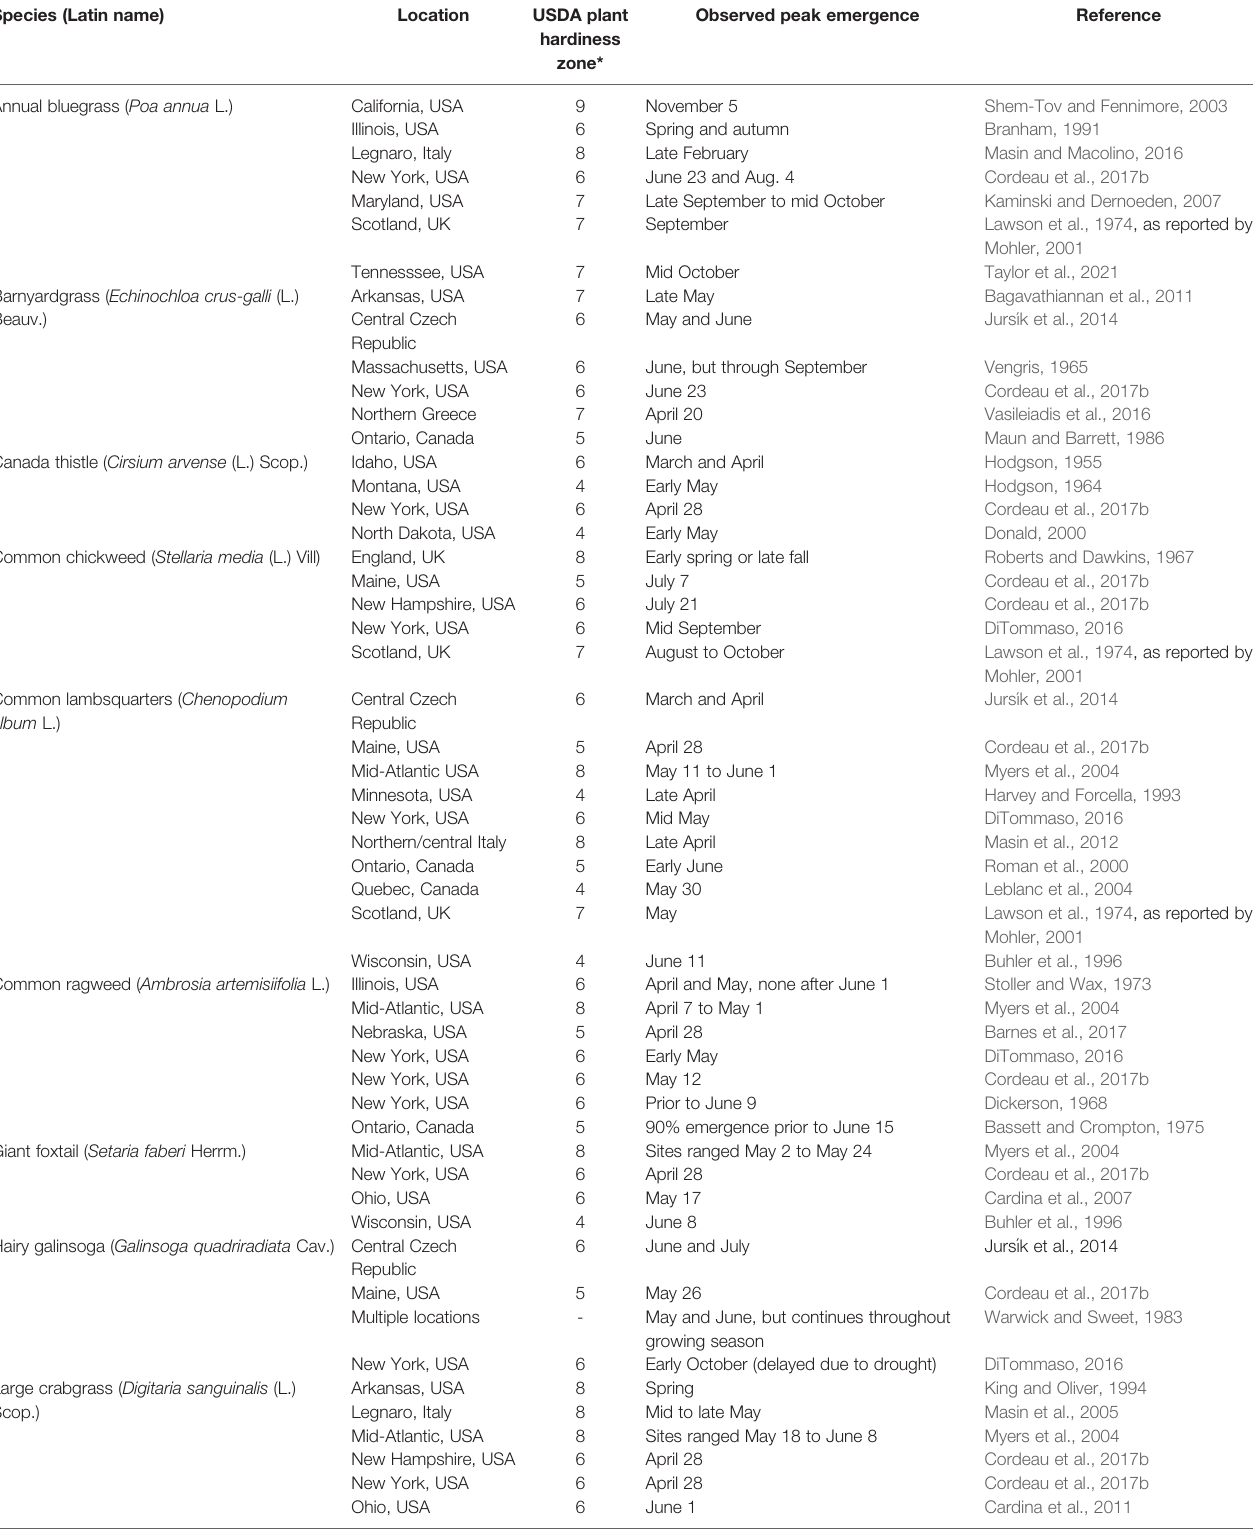
TABLE 1 | Comparison of peak emergence of target weeds from previous studies. Species (Latin